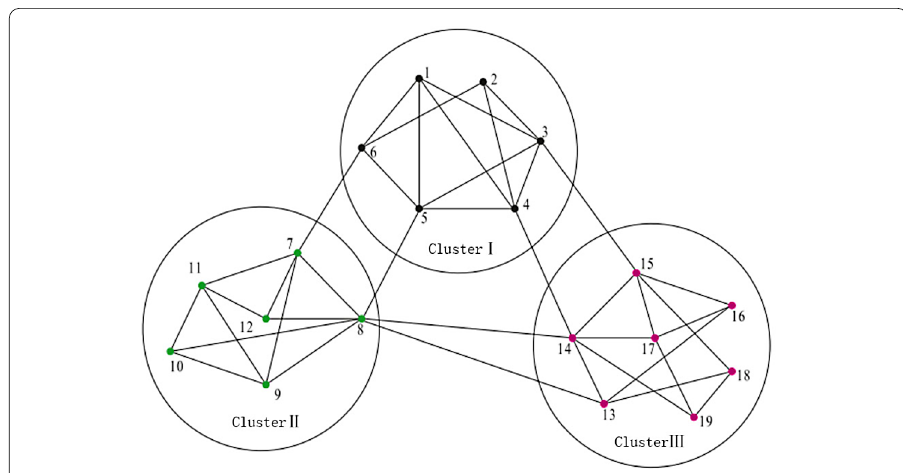
Figure 1 A BA scale-free network with three clusters consisting of 19